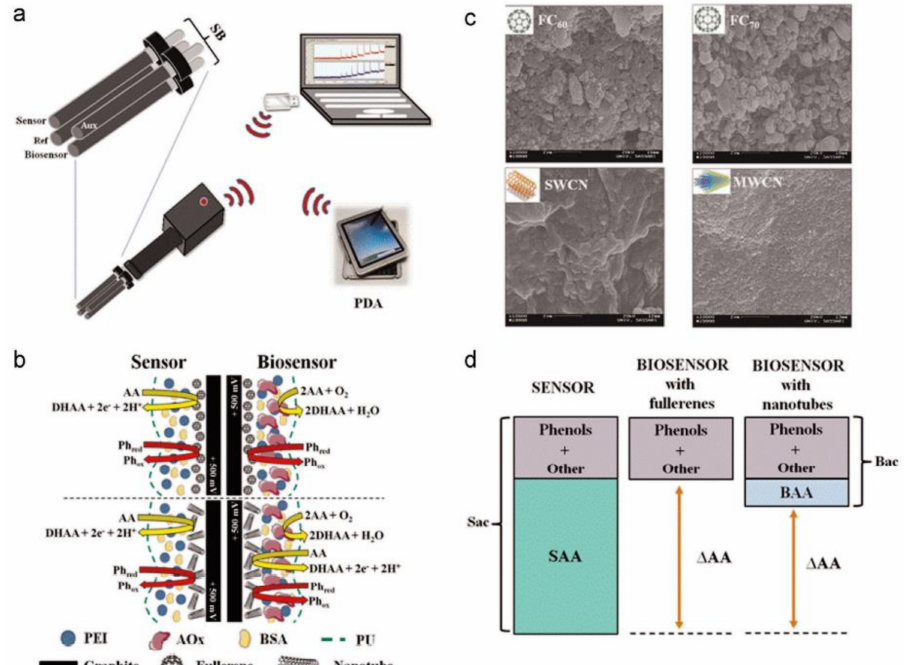
Figure 2. ( a ) Pseudoreference, working, and auxiliary electrodes; ( b ) CSEM images of biosensor surface modified with different materials. ( c ) Diagrammatic representation of the sensors with the modified surface; ( d ) working of the sensor. Reproduced from Reference [24] with